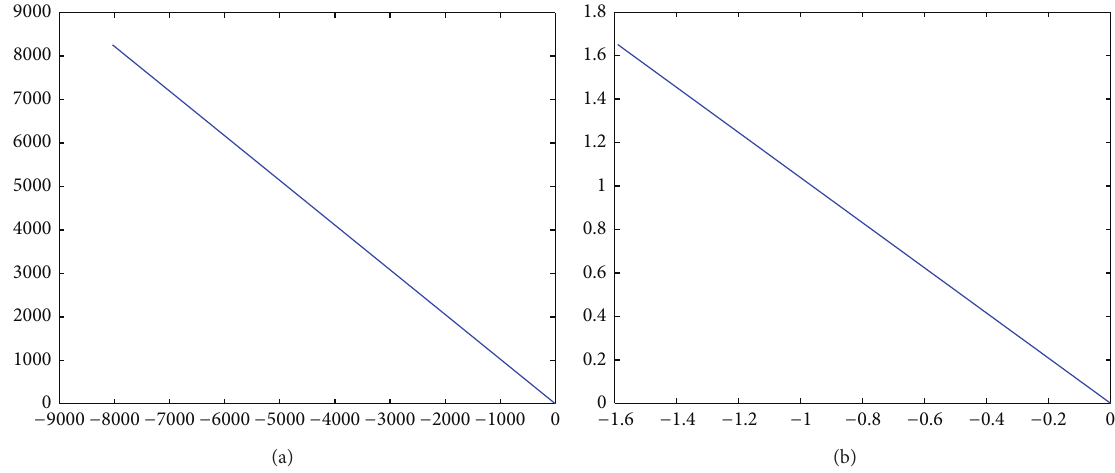
Figure 7: (a) A linear model about parameter scanning voltage of 𝑅1 from short circuit to open circuit. (b) A linear model about parameter scanning voltage from 5 k to open